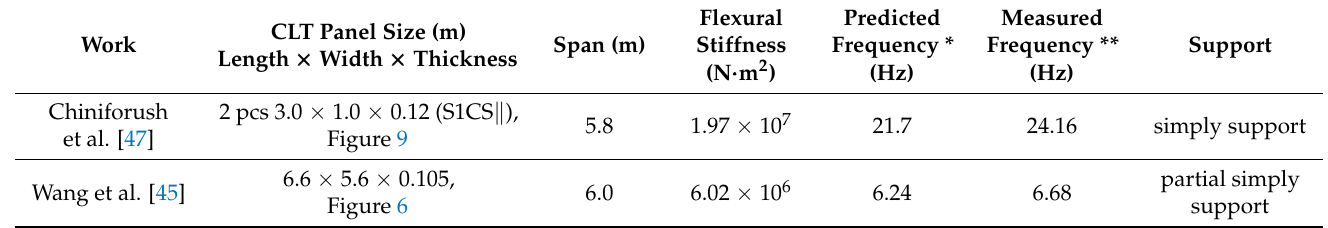
Table 14. The details and frequency results of the STC floors studied in Chiniforush et al. [47] and Wang et al.